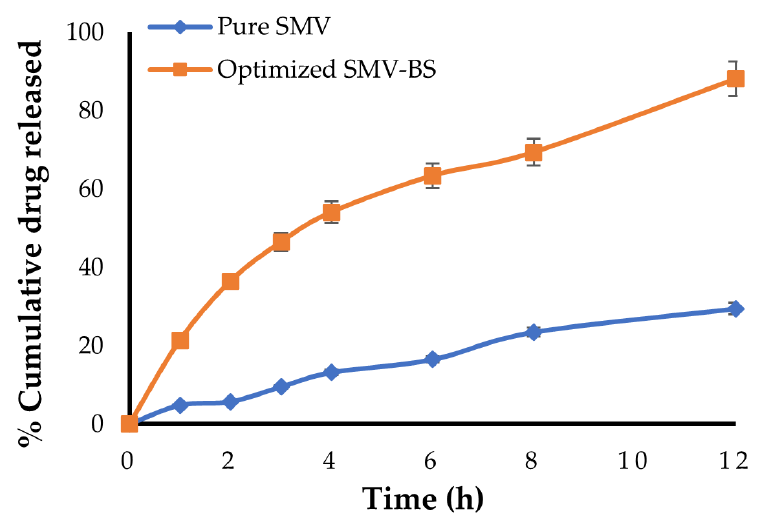
Figure 6. In vitro release profiles of pure SMV and optimized SMV-BS.